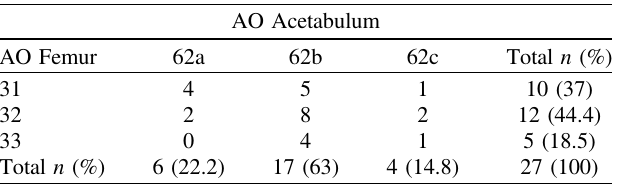
Table 3. Arbeitsgemeinshaft f ű r osteosynthesefragen (AO) types of the acetabular and femoral fractures.